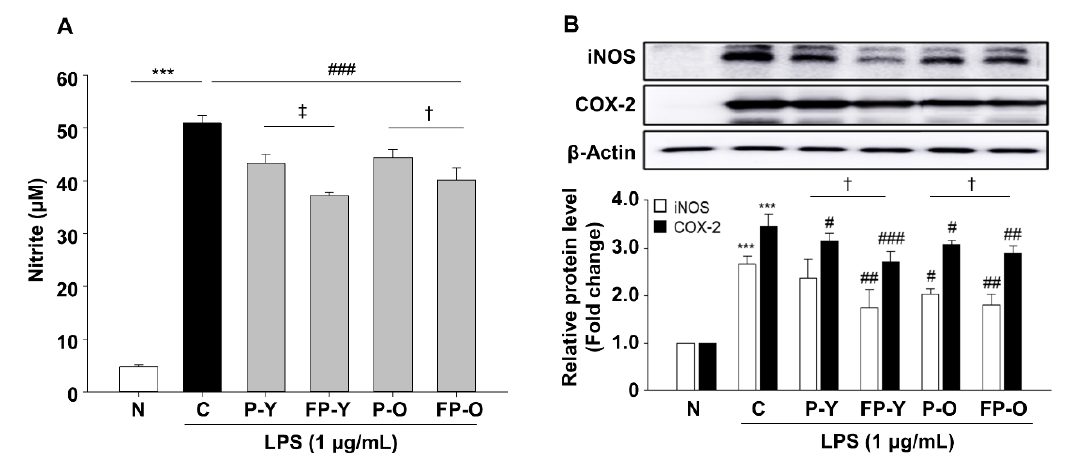
Figure 3. Effects of FP on LPS-induced NO production and iNOS, and COX-2 protein expression in RAW 264.7 cells. RAW264.7 cells were pretreated with P (-Y or -O) and FP (-Y or -O) extracts (500 µ g/mL) for 1 h, and then incubated with LPS (1 µ g/mL) for 18 h. ( A ) The nitrite levels in culture media were measured using Griess reagent. ( B ) The protein levels of iNOS and COX-2 were analyzed by immunoblotting in cell lysates. The band density was normalized to β -Actin followed by statistical analysis. *** p < 0.001 vs. N; # p < 0.05, ## p < 0.01, ### p < 0.001 vs. C. † p < 0.05 vs. P (-Y or -O), ‡ p < 0.01 vs. P-Y. Values are means ± SEM. Significant differences between the groups were determines by ANOVA followed by Duncan’s multiple range test. LPS, Lipopolysaccharides; iNOS, inducible nitric oxide synthase; COX, cyclooxygenase; N, Normal; C, Control; P-Y, Yellow Paprika; P-O, Orange Paprika; FP-Y, Fermented P-Y; FP-O, Fermented P-O.